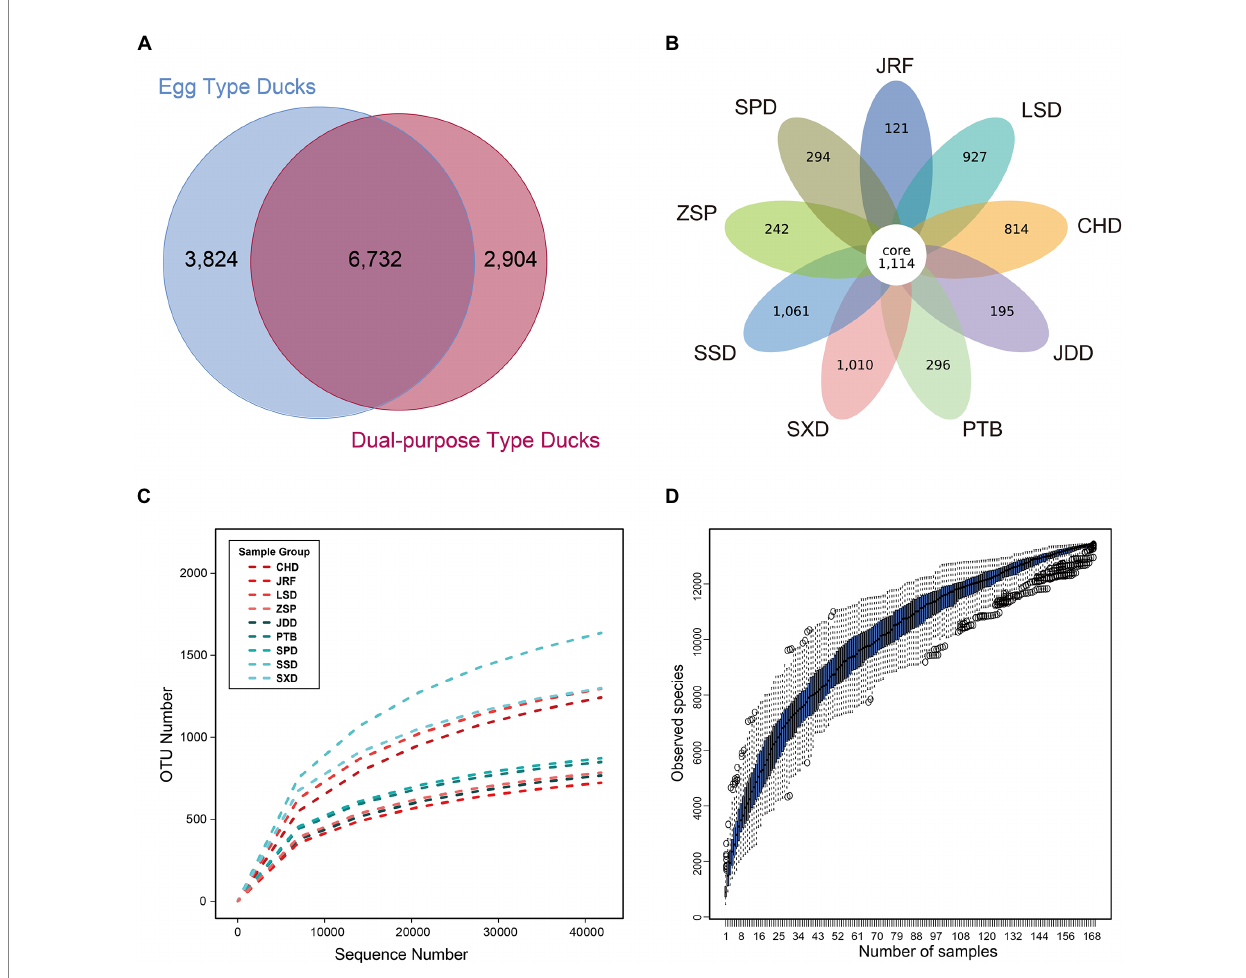
FIGURE 2 OTU classification and species richness analysis of the nine Chinese duck breeds. The Venn graph was drawn after homogenization processing for all samples. (A) Venn analysis of OTUs from dual-purpose and egg type ducks. (B) Venn analysis of OTUs from nine duck breeds. Each circle in the figure represents a group or breed, the numbers in circle and circle overlap represents the number of shared or unique OTUs in different samples. (C) Species rarefaction curves of the duck breeds. (D) Species accumulation curves of the current